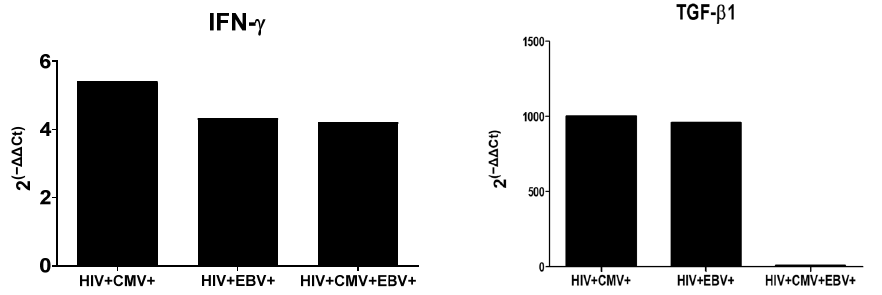
Figure 2. Fold change 2 ( − ∆∆ Ct) analysis of IFN- γ and TGF- β 1 in EBV/CMV co-infected groups as compared to HIV mono-infected group.